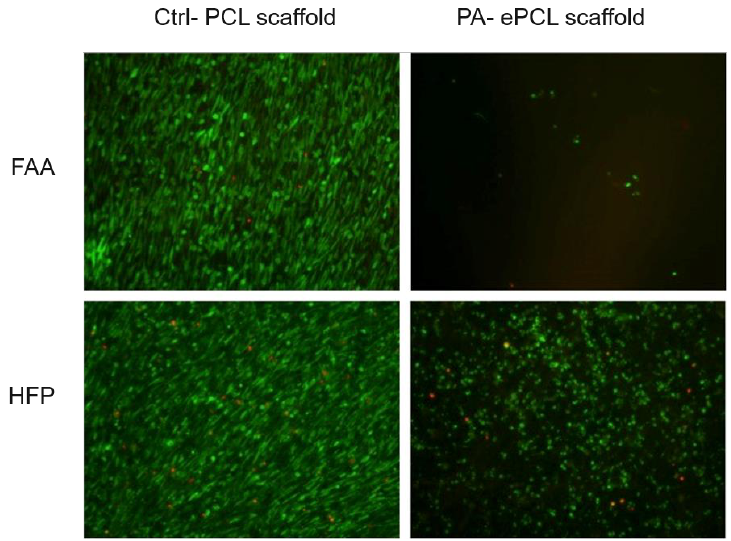
Figure 2. Effect of PAA on cell viability. Live/Dead staining of MC3T3 on Ctrl PCL scaffold with no PAA exposure ( A ) show robust cell attachment while PAA sterilized PCL scaffold (B) is profoundly cytotoxic.